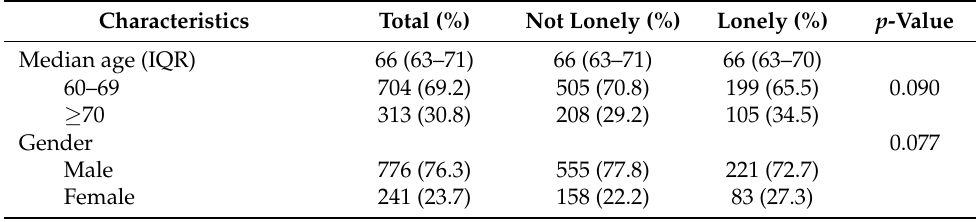
Table 1. Demographic characteristics of